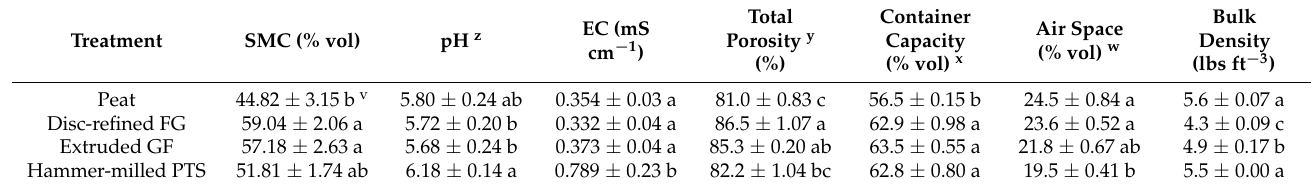
Table 1. Mean chemical properties (substrate moisture content (SMC), pH, and electrical conductivity (EC)) and physical properties ± standard error ( n = 3) at the time of seeding for each substrate treatment in objective one. All blends consisted of 70% peat 30% wood or perlite (by volume).